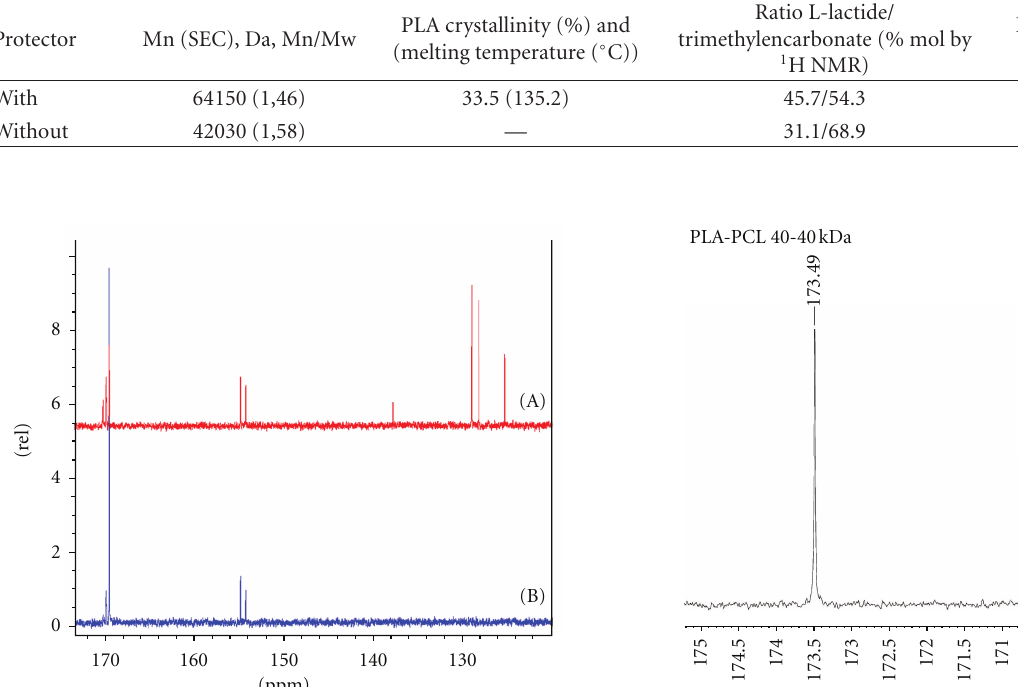
Figure 5: 13 C NMR spectra of diblock copolymer PLA-PCL synthe- sised with the use of α -methylstyrene as a protector and HBVE as an initiator (PLA